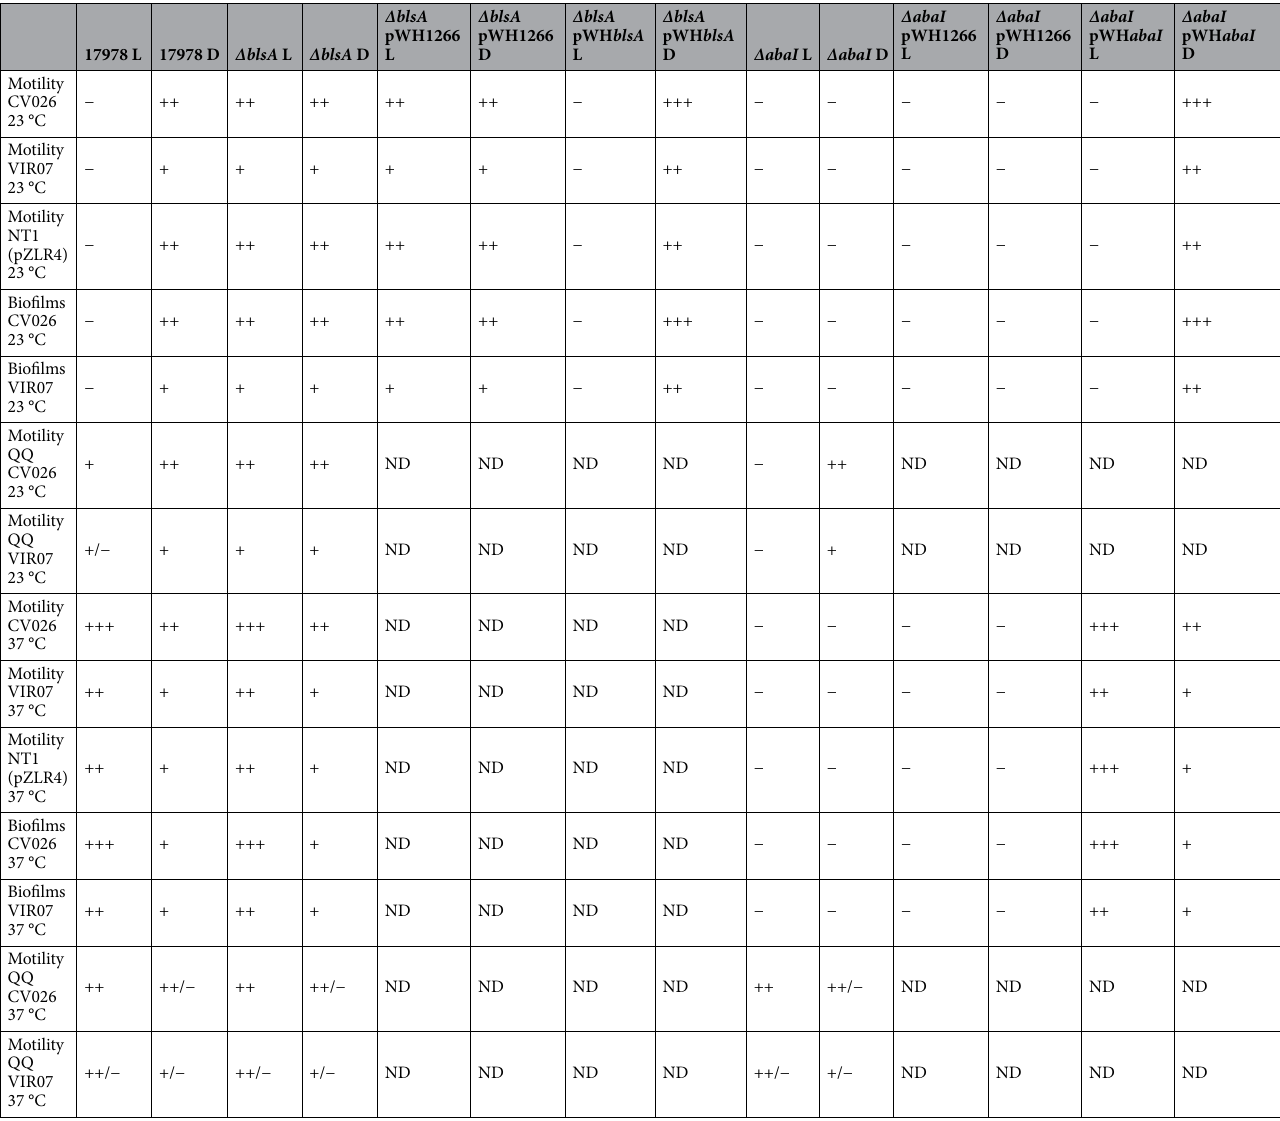
Table 1. Summary of AHLs detection using the different biosensors. ND non-determined. (−) no pigment production. The amount of + correlates with the level of pigment